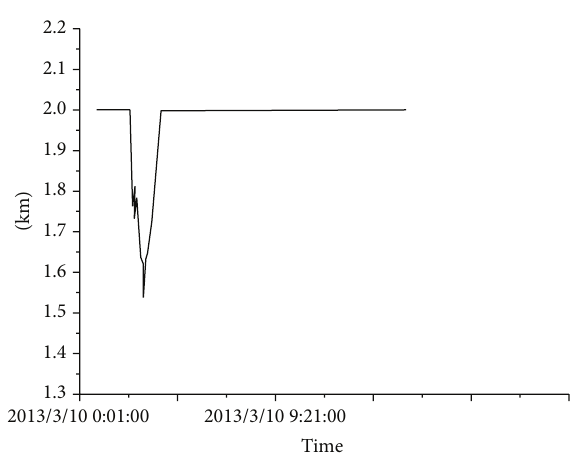
Figure 16: Vibration of 4# tower and T7 box